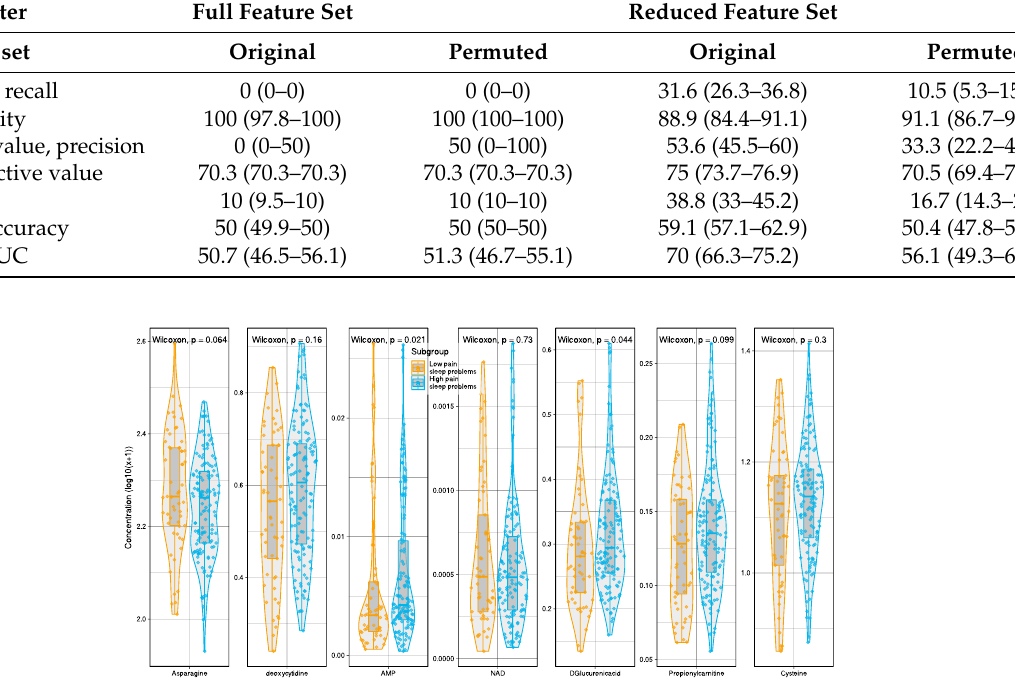
Figure 3. Raw data of the selected metabolomics features presented separately for the two pain and sleep-related subgroups. The transformed values (log10(x + 1)) are shown; for untransformed values of all metabolomic markers see Supplementary Figure S1. Individual data points are presented as dots on violin plots showing the probability density distribution of the variables, overlaid with box plots where the boxes were constructed using the minimum, quartiles, median (solid line inside the box), and maximum of these values. The whiskers add 1.5 times the interquartile range (IQR) to the 75th percentile or subtract 1.5 times the IQR from the 25th percentile. Statistical significances are shown at the top of each panel. The figure was created using the R software package (version 4.0.2 for Linux; https://CRAN.R-project.org/ [23]) and the R libraries “Boruta” (https://cran.r-pro- ject.org/package=Boruta [24]) and “ggplot2” (https://cran.r-project.org/package=ggplot2 [25]).